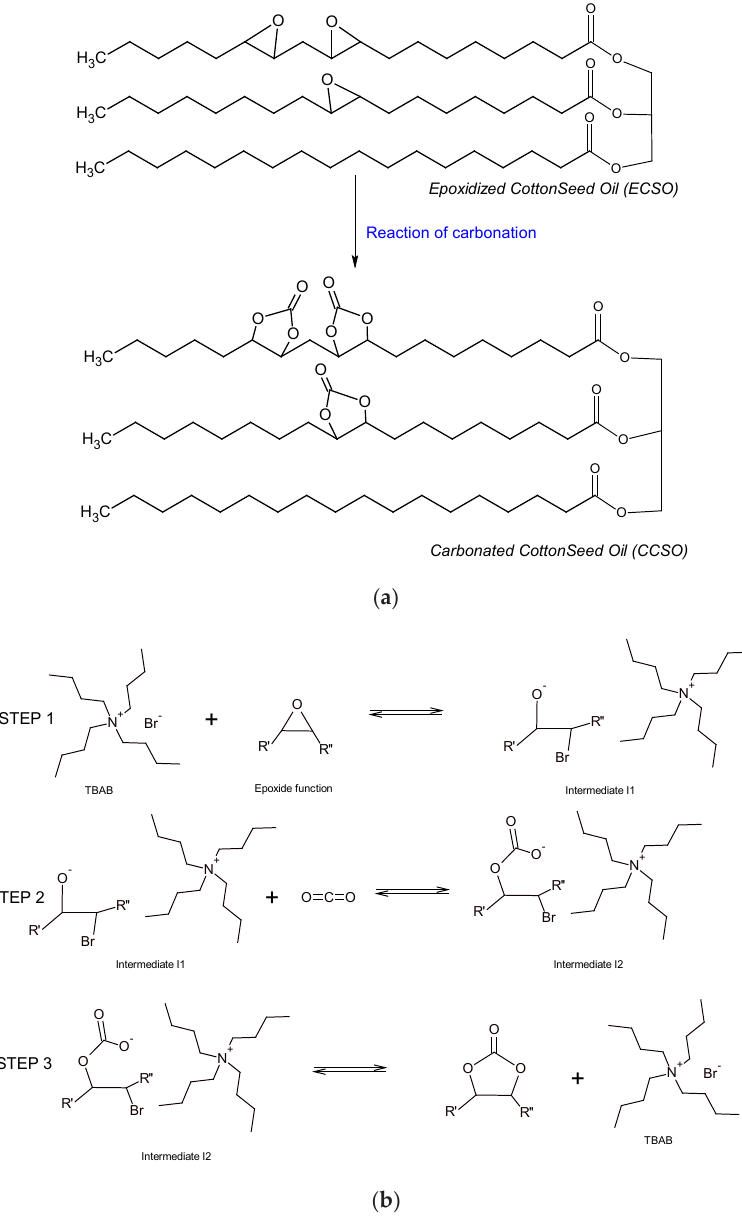
Figure 2. The applied reaction mechanism ( a ) simplified ( b ) detailed with catalyst [5]. The viscosity of the reaction mixture, which can be calculated based on the sum of weighted viscosities of the components varies in the spatial and temporal coordinates. Equation (1) presents how the reaction rate is calculated.